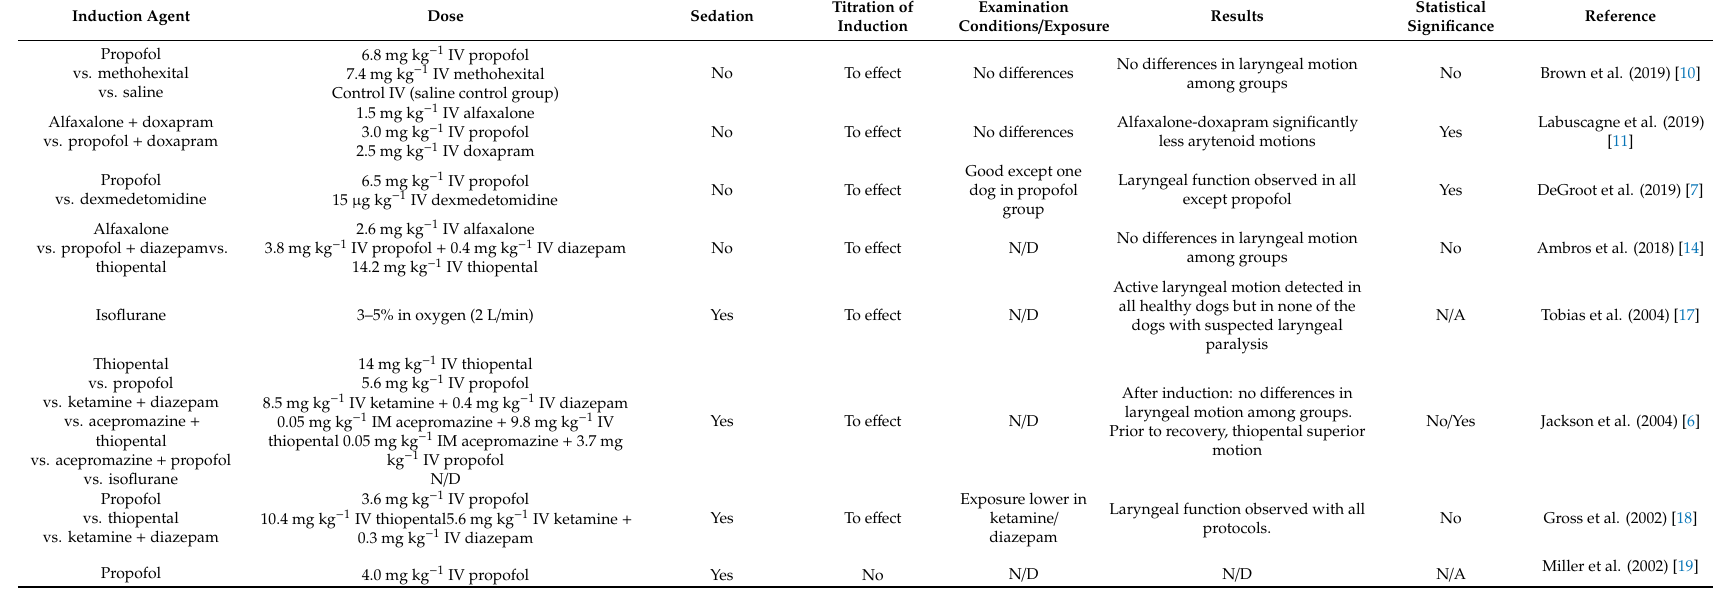
Table 3. Results and study features design from 12 studies evaluating the laryngeal function after the administration of induction agents. Induction Agent Dose Sedation Titration of Induction Examination Conditions / Exposure Results Statistical Significance Reference Propofol vs. methohexital No Brown et al. (2019) [10]